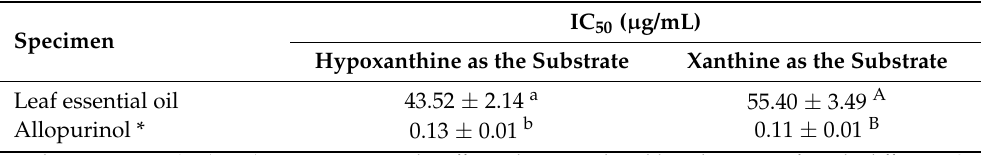
Table 1. IC 50 values of Pistacia chinensis leaf essential oil against xanthine oxidase.